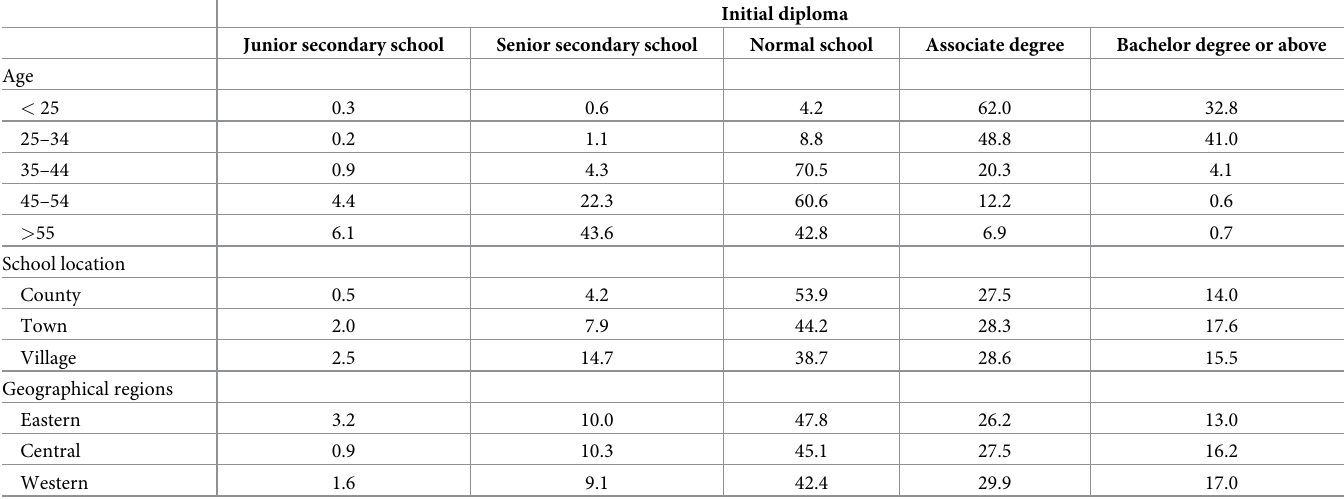
Table 6. Initial diploma by age, school location, and geographic regions.